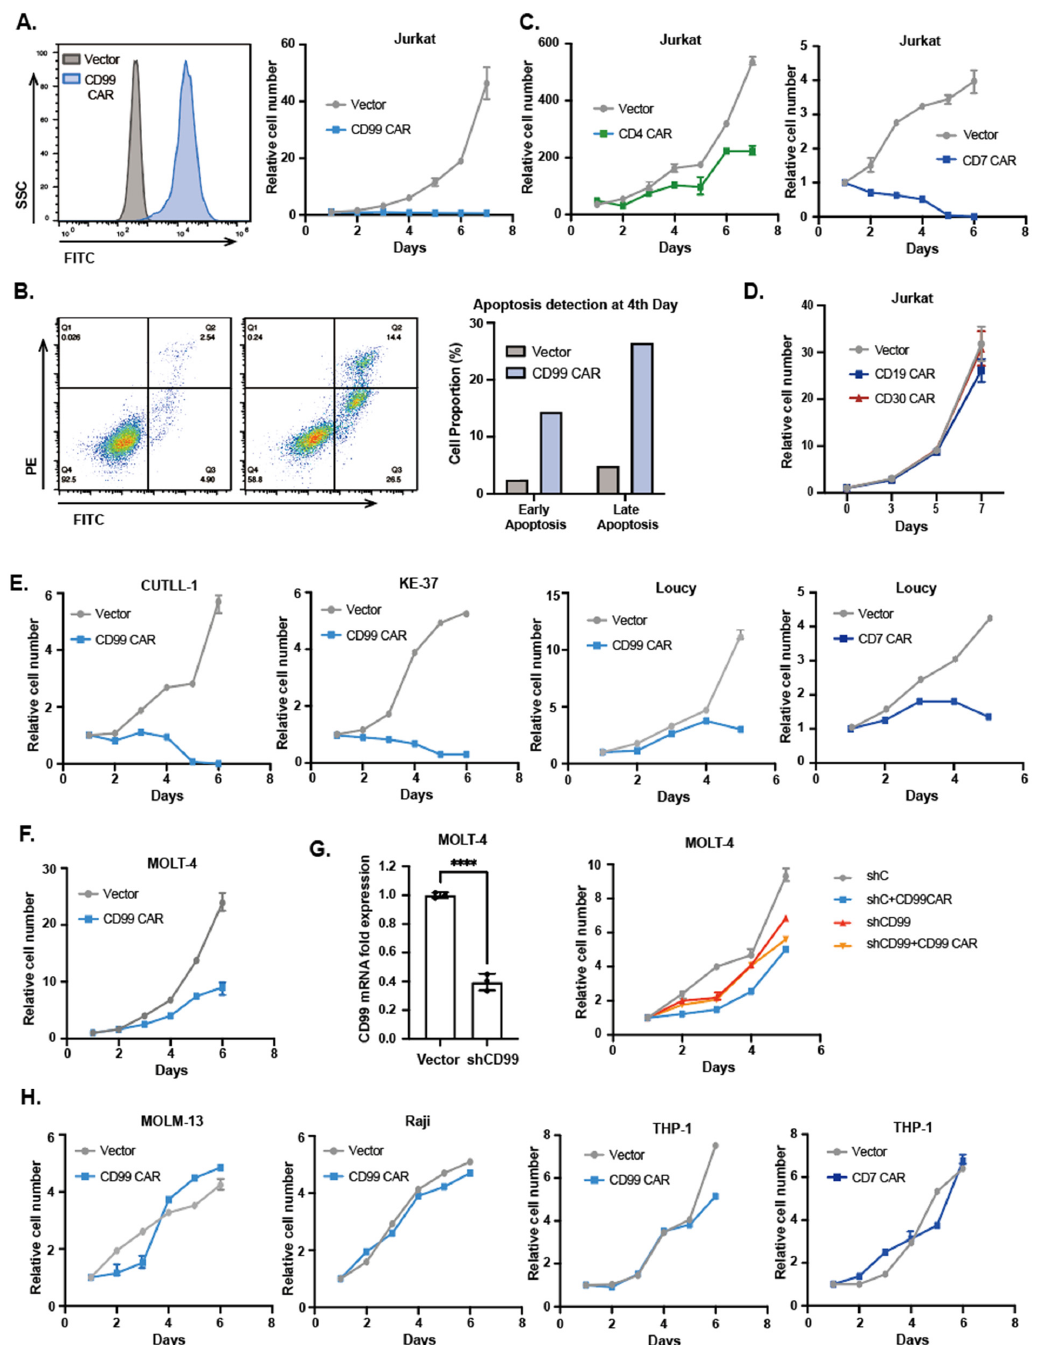
Figure 1. Cell proliferation and transfection efficiency of Jurkat cell lines after transduction with CD99. The cell count was performed at 24 h after transduction and once a day. The transfection efficiency was assessed at 48 h after transduction and once every two days ( A ). Apoptosis assay detected via Flow cytometry at 96 h after transduction ( B ). Cell proliferation of Jurkat cell lines after transduction with CD4 or CD7. The cell count was performed at 24 h after transduction and once a day ( C ). Relative cell growth of Jurkat cell lines with CD19 CAR, or CD30 CAR. The cell count was performed at 24 h after transduction and once every two days ( D ). Cell proliferation of other T-ALL cell lines after transduction with CD99 or CD7 ( E ). Cell proliferation of MOLT-4 cell lines ( F ) and CD99 knock-down stabled MOLT-4 cell lines ( G , right ) after transduction with CD99; RT-qPCR detected knock-down efficiency ( G , left ). Data are mean ± SD (Two-tailed unpaired Student’s t test, **** p < 0.0001). Cell proliferation of non-T-ALL cell lines after transduction with CD99 or CD7 ( H